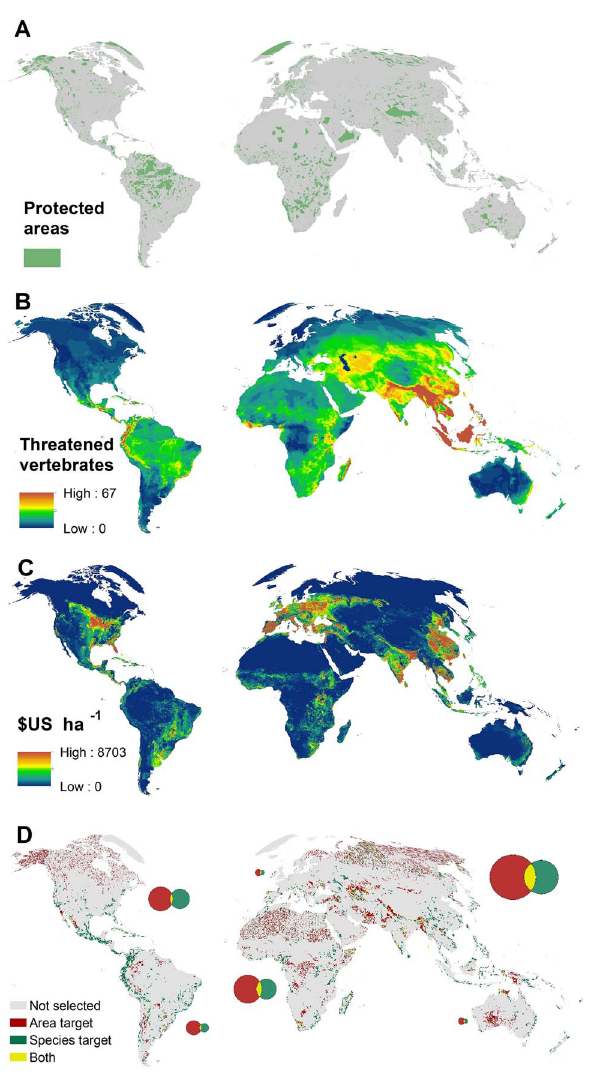
Figure 1. Key data inputs and output map from the systematic conservation planning framework. (A) Protected areas mapped using polygons and buffered points for nationally designated protected areas [3]. (B) The number of native and extant globally threatened terrestrial and freshwater birds [8], mammals [10], and amphibians [10] per grid square. (C) The average annual agricultural opportunity cost of protecting each 30 km grid square in 2012 $ US [17]. (D) The distribution of priorities for establishing new protected areas to meet the national- level 17% targets under Aichi target 11 at minimal cost and ignoring ecological representation (red), for covering threatened species (green), and locations selected under both scenarios (yellow). The sizes of the circles in the Venn diagrams are proportional to the area required in each of the three categories. the species’ distribution overlapped with the protected area network. To set adequacy targets we followed the method of Rodrigues et al. [23] to scale the target to the species’ overall geographic range size. Complete (i.e., 100%) coverage by protected areas was required for species with a geographic range of , 1,000 km 2 . For wide-ranging species ( . 250,000 km 2 ), the target was reduced to 10% coverage, and where geographic range size was intermediate between these extremes, the target was log-linearly interpolated.